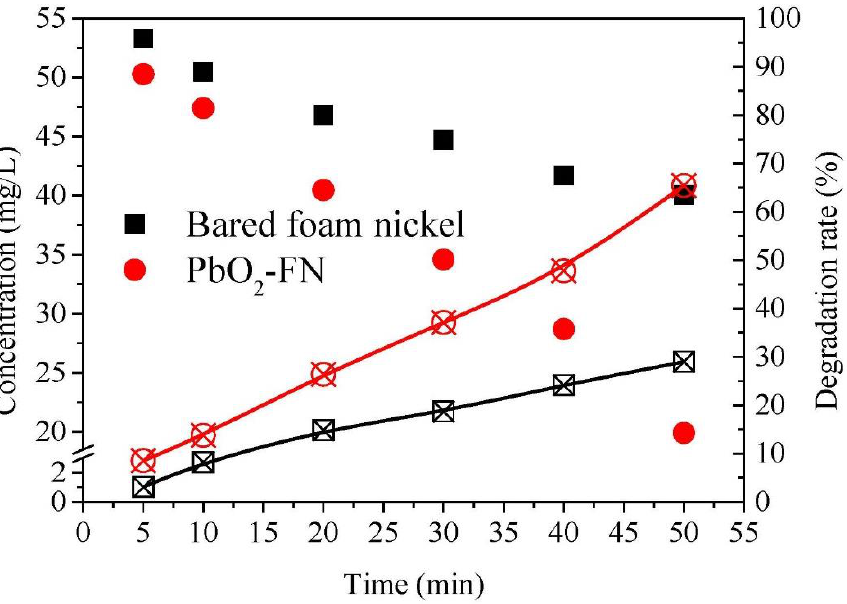
bare nickel Figure 1. Comparison of degradation efficiencies of norfloxacin at the electrodes of PbO 2 -FN and bare nickel foam.